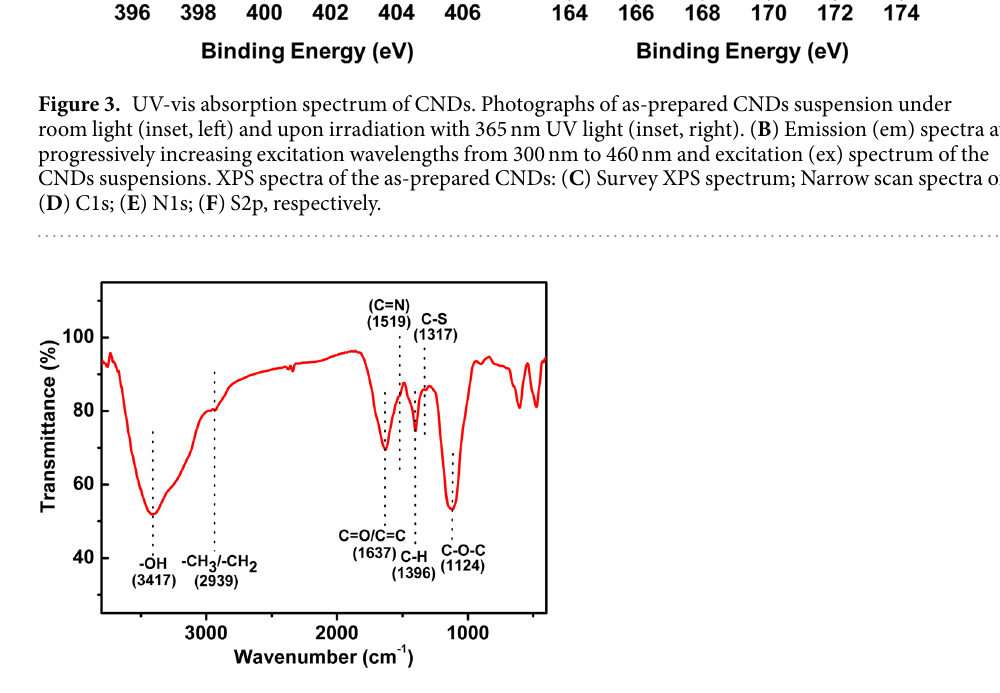
Figure 4. FTIR Spectra of the as-prepared